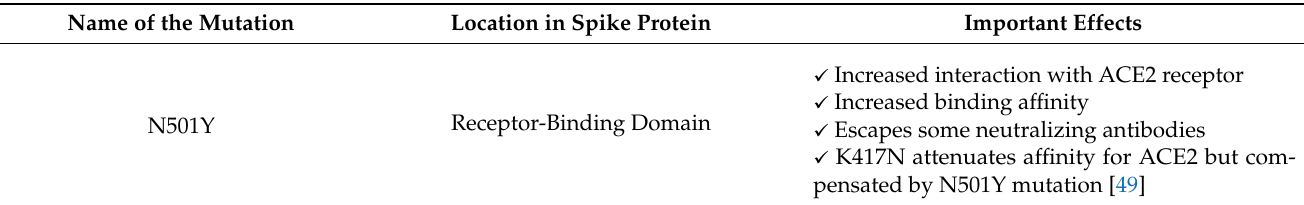
Table 2. Predominant Spike Mutations associated with SARS-CoV-2 variants.